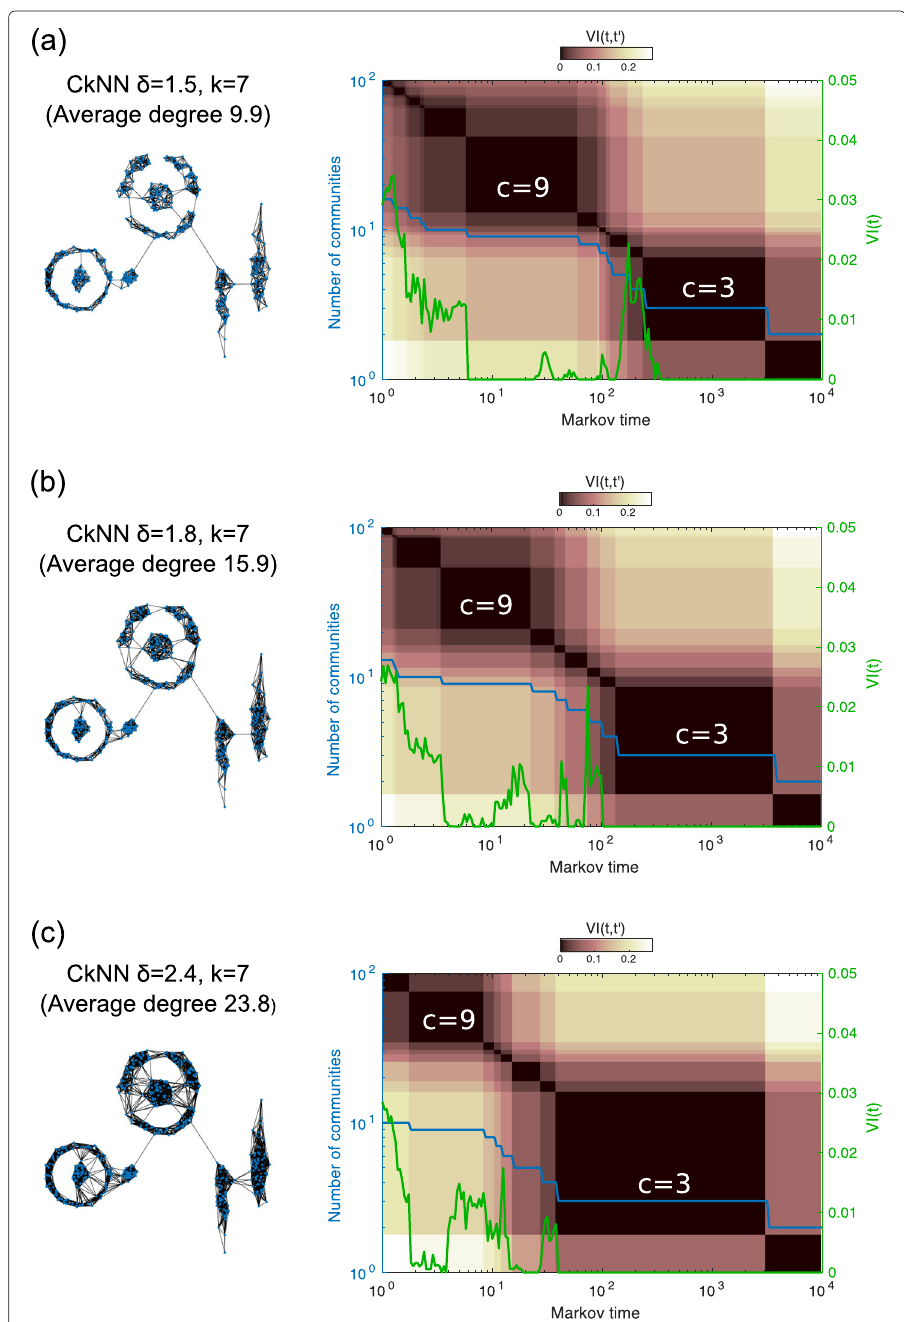
Fig. 5 The multiscale character of Markov Stability alleviates the sensitivity to the parameters of graph construction. Using the same synthetic dataset as in Fig. 3, MS finds the robust partitions and scales in the data ( c = 3 and c = 9) in an unsupervised manner for CkNN graphs constructed with a range sparsities as given by varying the parameters: k = 7 and δ = 1.5,1.8,2.4 in ( a ), ( b ) and ( c ), respectively. Markov time, as a resolution parameter, allows the community algorithm to reveal the local and global properties of the graph constructed from the